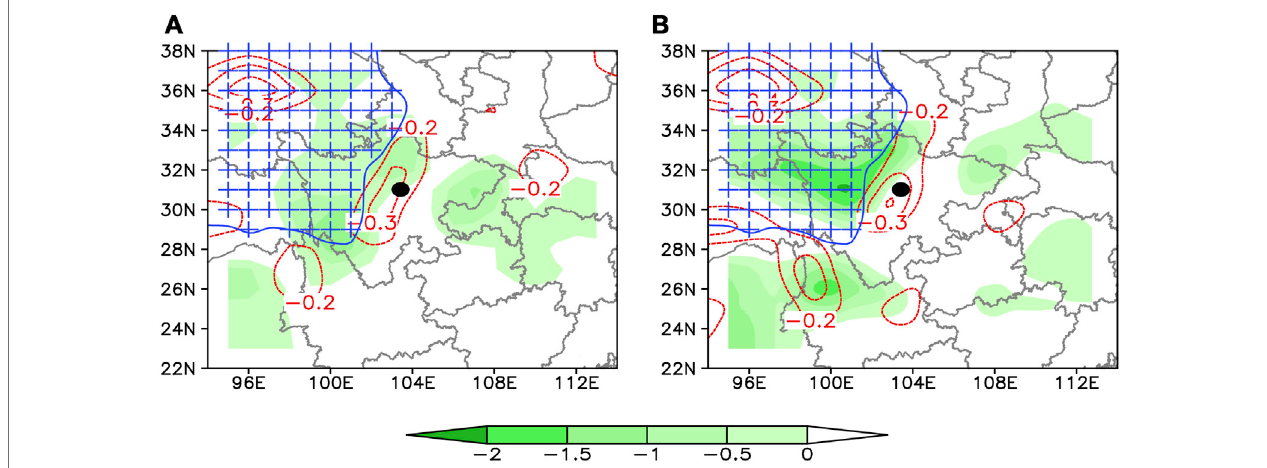
FIGURE8| Divergenceofthewatervapor fl ux(shading,units:10 – 8 g hPa − 1 cm − 2s − 1 )andverticalvelocity(reddashedlines,units:Pa s − 1 )at700 hPaderivedfrom theNCEPFNLdatasetsfor (A) 06:00UTConMay11,2008and (B) 06:00UTConMay12,2008.TheblueplussignsandbluelinesindicatetheTibetanPlateauandthe black dot is the epicenter of the earthquake.